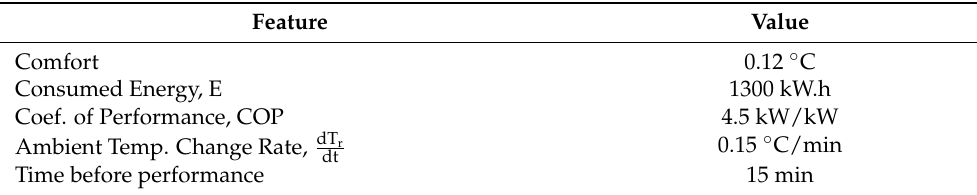
Table 4. Model prediction applying optimal operational modes.